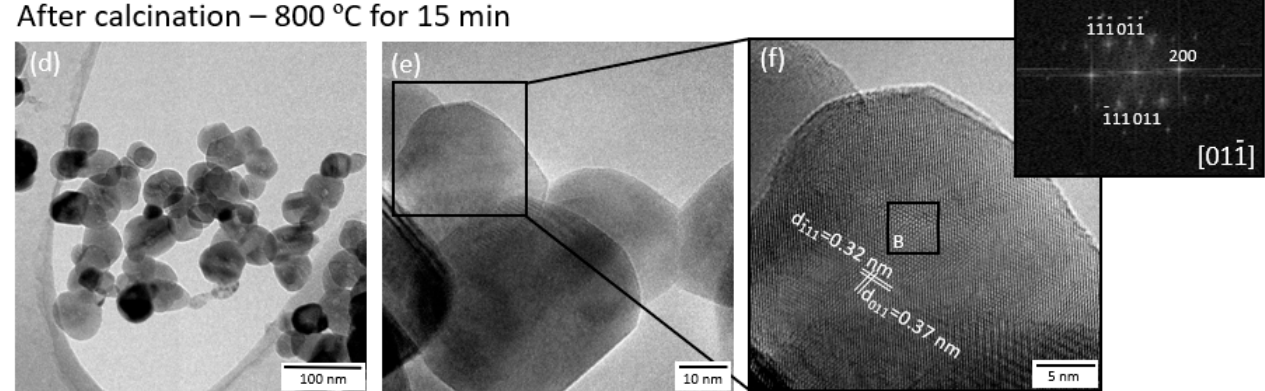
Figure 5. TEM images of the as-synthesized ZrO 2 nanoparticles before and after calcination at 800 °C for 15 min. ( a ) Bright-field TEM image of the ZrO 2 nanoparticles before calcination and ( b ) and ( c ) high-resolution TEM images of the ZrO 2 nanocrystals. ( d ) Bright-field TEM image of the ZrO 2 nanoparticles after calcination and ( e , f ) high-resolution TEM images of the ZrO 2 nanocrystals. The insets in ( c , f ) show the FFT images of the areas (black squares) indicated as ( A , B ),